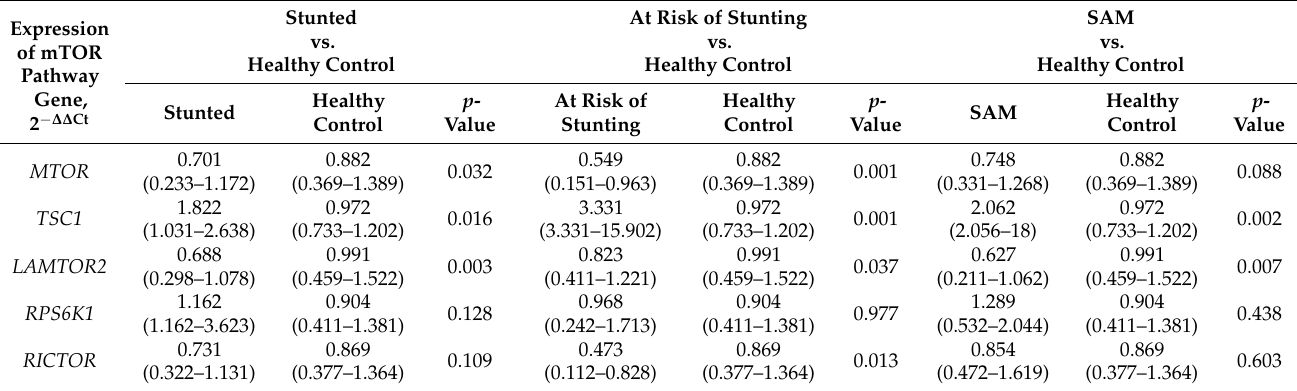
Figure 3. Statistical correlations between activity of p-mTORC1 with the anthropometric indices of LAZ, WAZ and WLZ. Correlation coefficient and the p -value shown is the result of Spearman-Rank Correlation between the activity of p-mTORC1 with each of the anthropometric indices. The colored circles indicate the individual activity of p-mTORC1 for the respective anthropometric indices of the study participants. Table 2. Comparison of the expression of the selected mTOR pathway genes ( MTOR , TSC1 , LAMTOR2 , RPS6K1 and RICTOR ) between each of the three malnourished cohorts with the healthy control